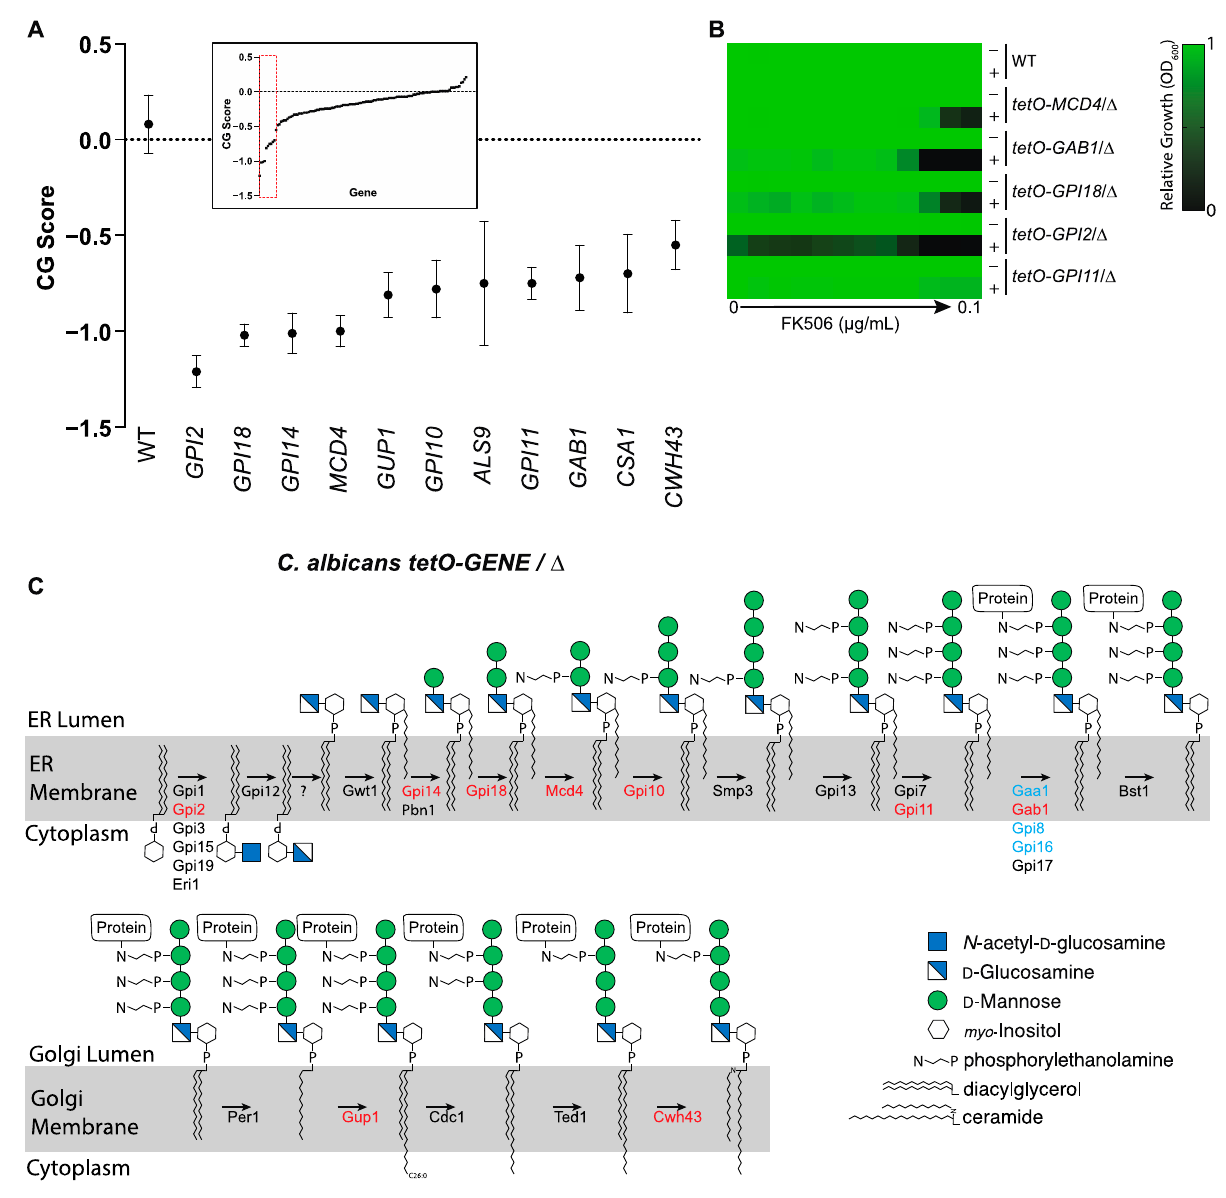
Figure 3. Transcriptional repression of diverse GPI-anchor biosynthesis genes sensitizes C. albicans to MGX and FK506. ( A ) Screen of GPI-anchor focused library. Conditional expression strains were grown in the presence or absence of FK506 (100 ng/mL) to inhibit calcineurin and in the presence or absence of DOX (5 µ g/mL) to repress target gene expression. Growth was assessed by OD 600 after 24 h. Chemical genetic (CG) interaction scores are displayed as the difference between expected and observed relative growth according to a multiplicative model. Data are mean CG Score ± SEM for triplicate wells from a representative experiment. Strains with statistically significant negative CG scores are indicated (unpaired t-test, Holm–Š í d á k’s multiple comparison test, p < 0.05) are indicated. Inset depicts values obtained for entire library. Gene names based on the respective S. cerevisiae homologues are indicated for C1_04280 ( GPI18 ), C_505040 ( GPI10 ) and C503120 ( GAB1 ). ( B ) MIC testing confirms transcriptional repression of multiple GPI anchor biosynthesis genes confers hypersensitivity to FK506. C. albicans or tetO-GENE/ ∆ mutant derivatives were grown in YPD at 30 ◦ C in the presence or absence of 0.05 µ g/mL DOX, then sub-cultured into YPD medium ± 5 µ g/mL DOX and a two-fold dilution series of FK506. Growth was determined by OD 600 after 24 h and normalized to vehicle control wells. Data are mean relative growth for triplicate wells from a representative experiment. ( C ) Schematic depiction of GPI anchor biosynthesis. Legend depicts